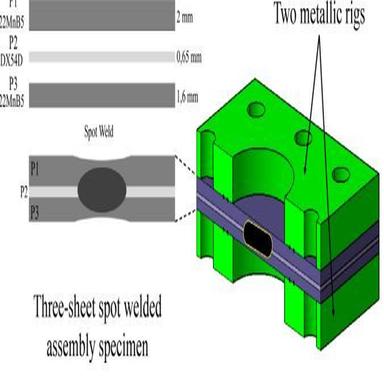
Studied spot welded specimen.